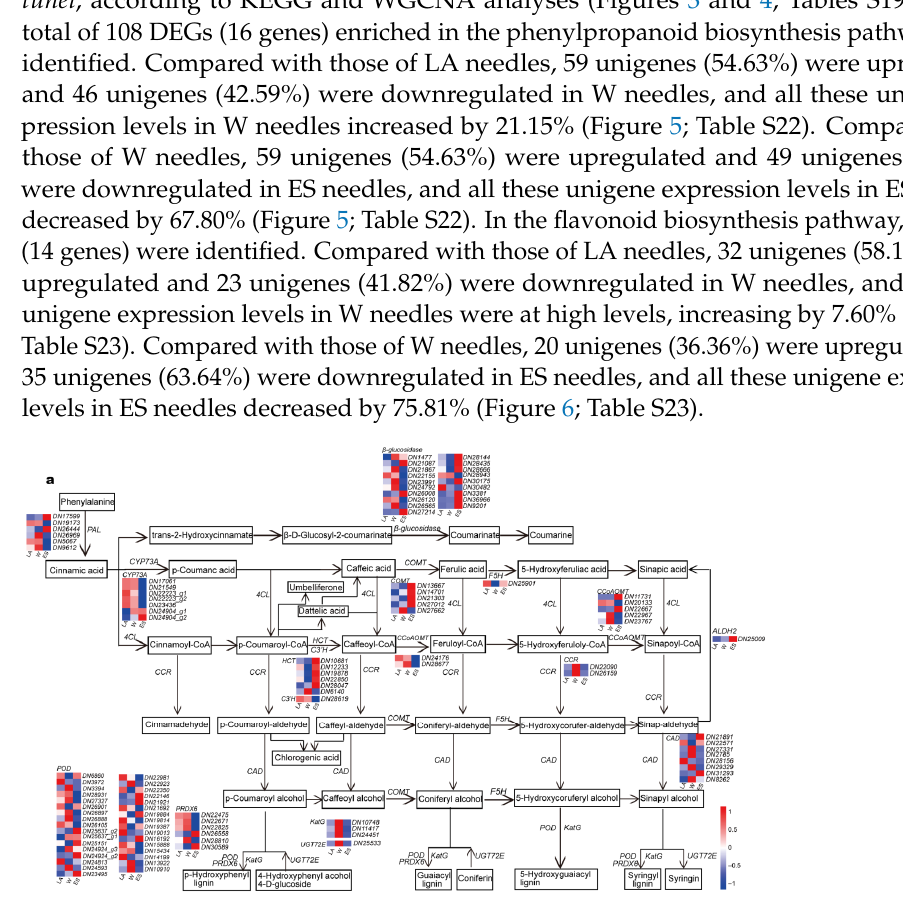
heatmap of differentially synthesized metabolites (DSMs) involved in phenylpropanoid biosynthesis. Heatmap represents metabolite content after normalizing the row data. The text below the heatmap indicates the sampling time, and the text to the right of the heatmap indicates the metabolite. Sample abbreviations are as follows: ES, early spring; LA, late autumn; and W,